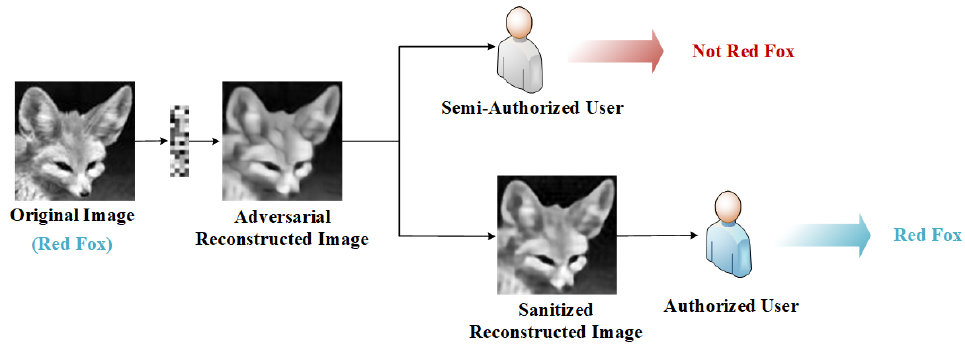
Figure 1. Framework of the proposed method .